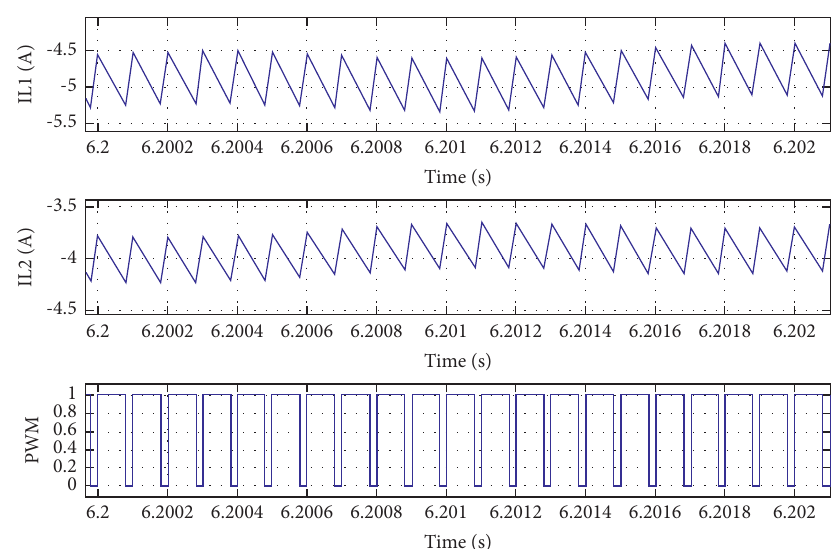
Figure 15: Inductor currents I L1 and I L2 with switching PWM during regenerative braking.